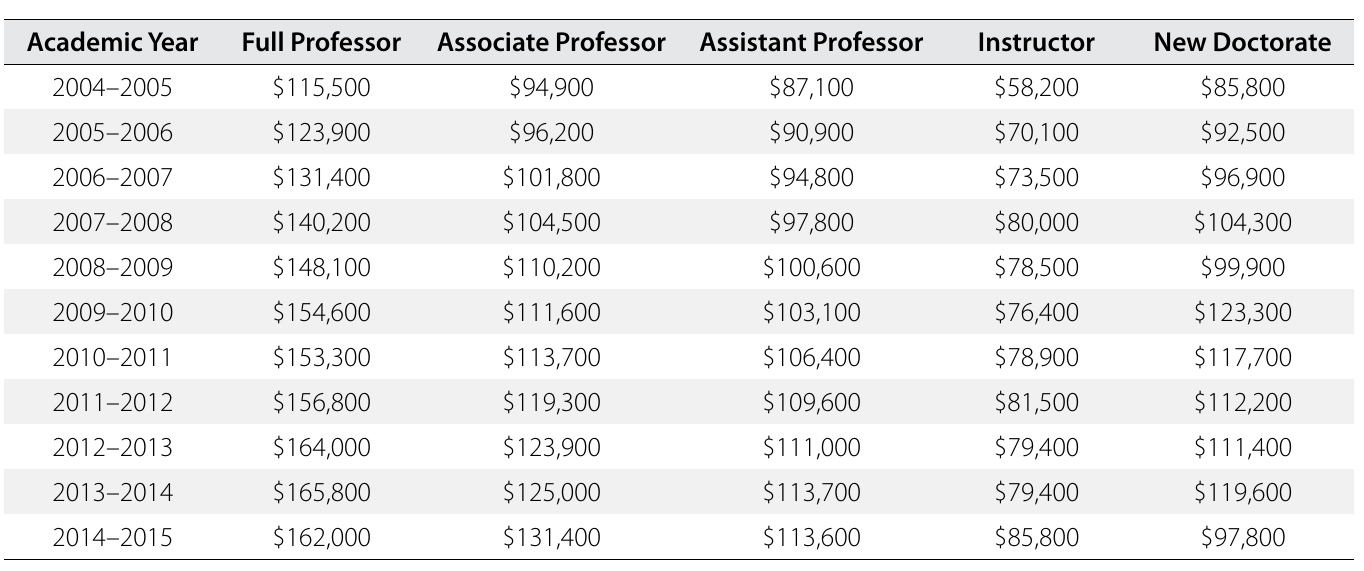
Table 5. Average Entrepreneurship Faculty Salaries at AACSB Schools 2004–2015 (9-month